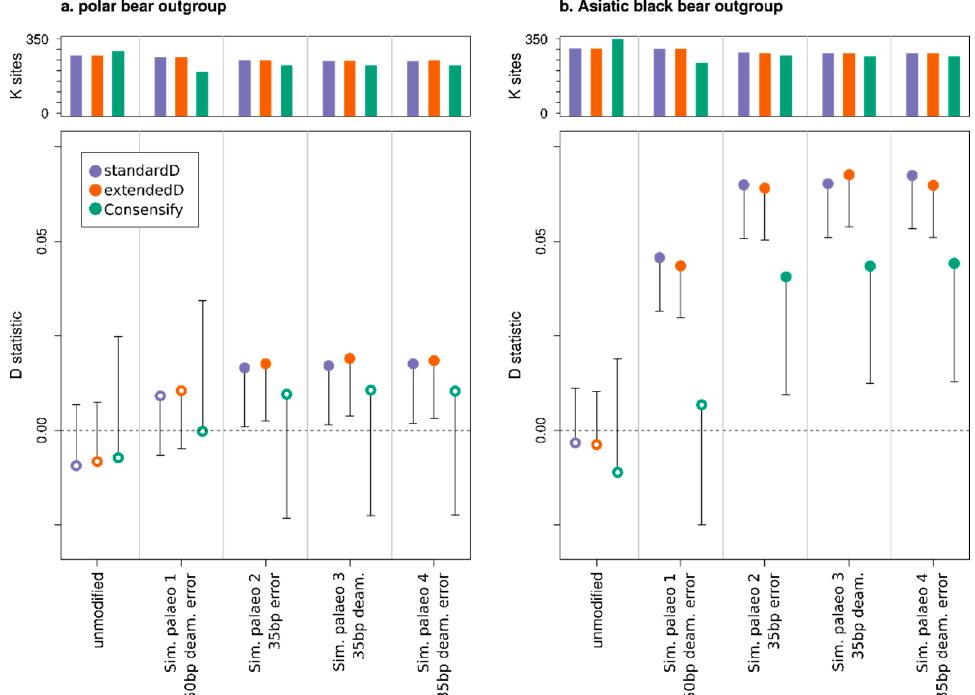
Figure 4. Effect of Consensify on D statistic tests of admixture, evaluated using simulated palaeogenomic data. The tests are based on three brown bears with the relationship: (((P1 = Italy,P2 = Slovenia),P3 = Sweden),P4 = outgroup). Each panel displays results calculated using different outgroups: the closely related polar bear ( a ) and the more distantly related Asiatic black bear ( b ). The upper plot of each panel shows the number of D statistic informative sites (ABBA+BABA, y axes in thousands of sites) counted for each D statistic comparison (separated by grey vertical lines). For each comparison, three results are displayed sequentially from left to right, corresponding to the standard D statistic, the extended D statistic with error correction, and the D statistic calculated using Consensify. The lower plots show D values (y axes) as coloured points. Single error bars extending toward zero show the weighted block jackknife standard error multiplied by three, with error bars that bisect y = 0 (dashed horizontal line) being non-significant (Z < 3). Significant and non-significant D values are further indicated by closed and open points, respectively. The leftmost comparisons in each panel corresponds to the original, high-quality dataset, and does not provide evidence of admixture in any test. For each adjacent comparison, data from the Italian brown bear has been modified in silico to mimic specific properties of palaeogenomic datasets (x axes): short fragment length (35 or 50 bp), C → T substitutions increasing exponentially towards the terminal fragment ends (deamination), and increased global sequencing error (error). Any significant D values are therefore false positives resulting from the data modification. Note that y axes are consistent between both panels ( a , b ).